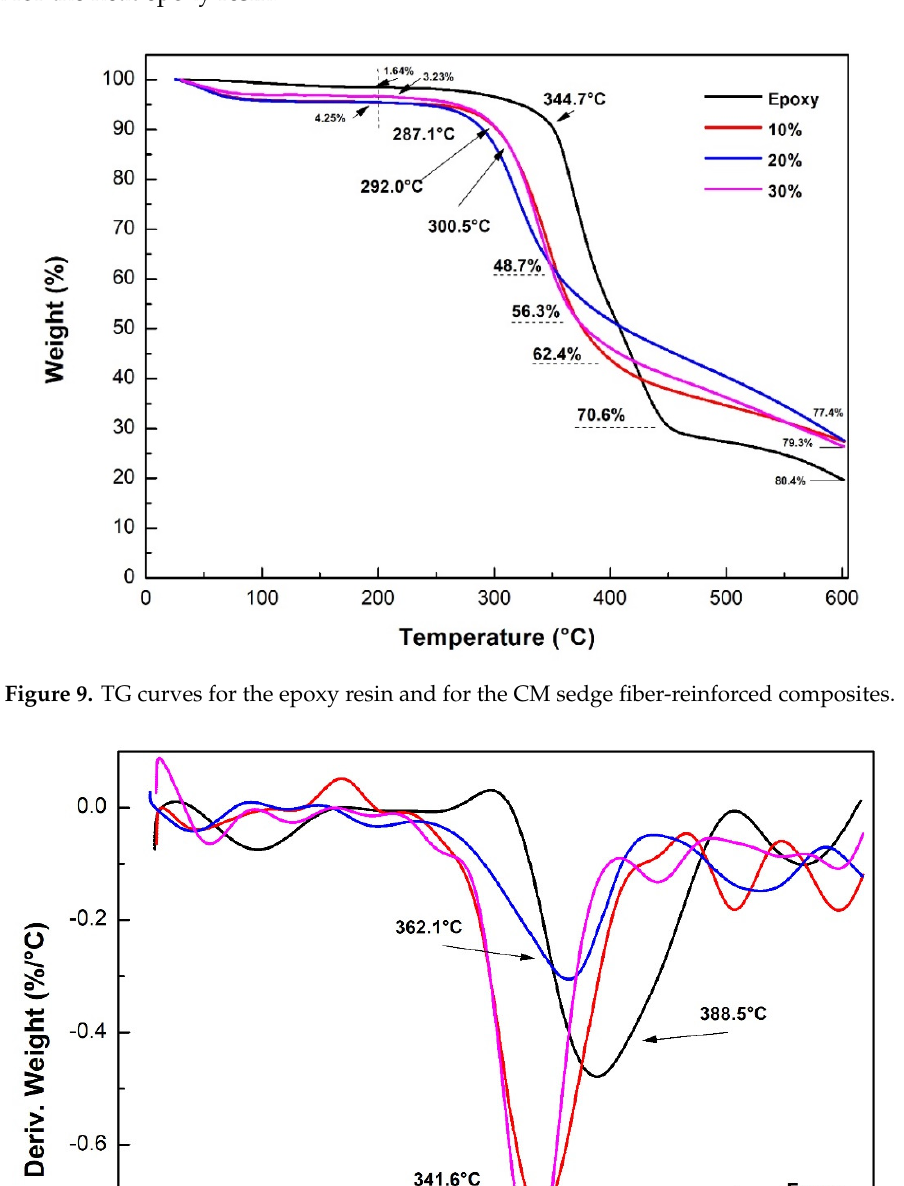
Table 12. Thermogravimetric parameters for the neat epoxy and the CM sedge fiber-reinforced composite.